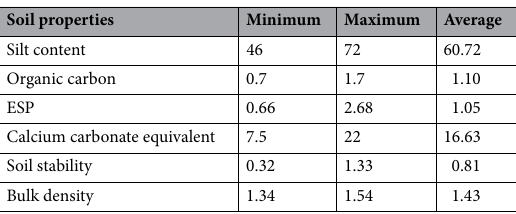
Table 10. The physical–chemical soil properties of the location of collapsed pipes, gully heads, and landslides in the study area.